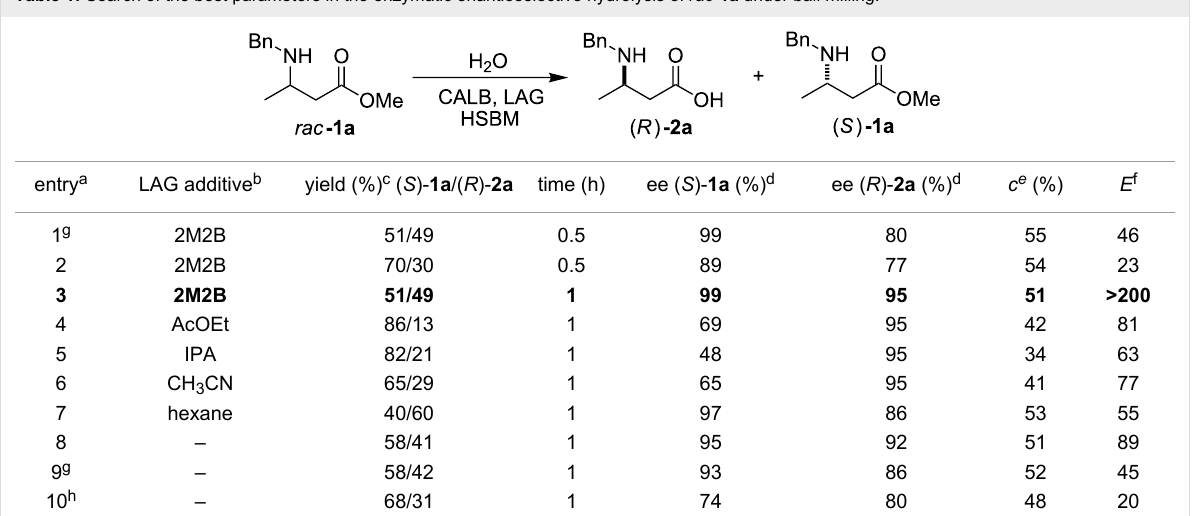
Table 1: Search of the best parameters in the enzymatic enantioselective hydrolysis of rac - 1a under ball milling.